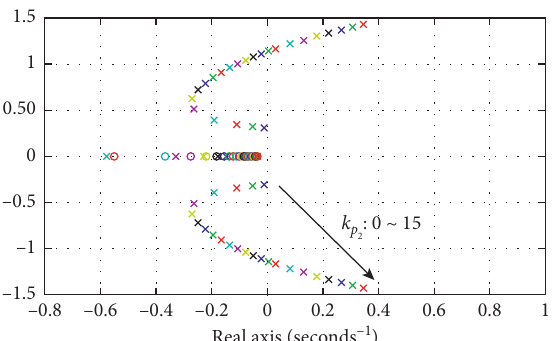
Figure 15: The change of the zero-pole diagram of the speed control closed-loop when the k